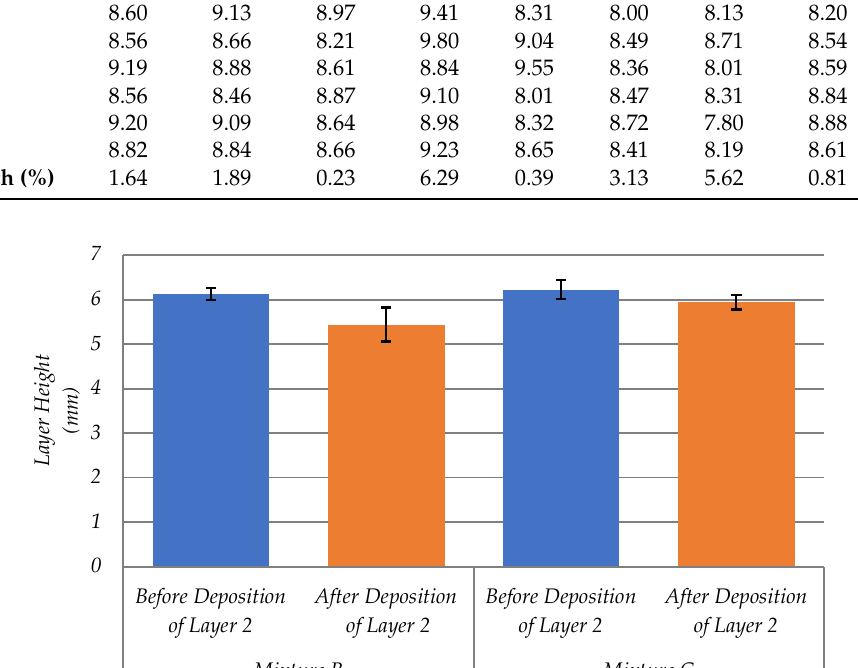
Figure 9 shows height data for layer 1 after depositing layer 2 for samples printed using mixtures B and C. The error bars indicate the standard deviation of the respective samples in Figure 9. The reductions in height for layer 1 were 11% for the samples printed using mixture B and 5% for the samples printed using mixture C. Samples printed using mixture C showed much better shape stability than samples printed using mixture B.